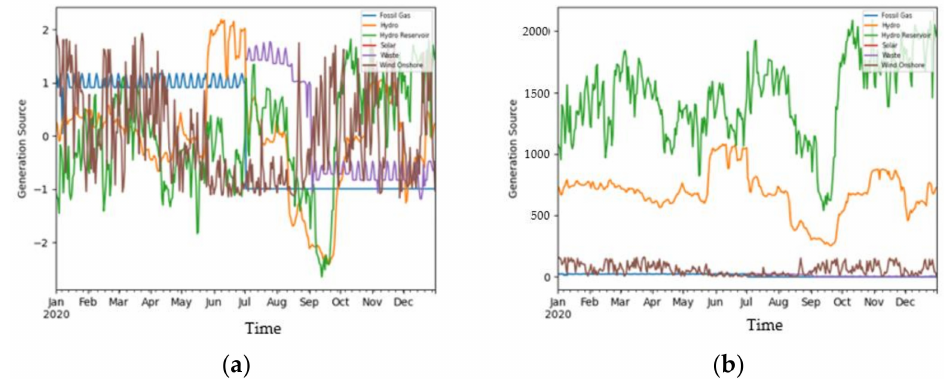
Figure 5. This figure represents the Norway (NO1) electricity generation. ( a ) Shows an approach using data standardization which has been defined in Formula (3); ( b ) Shows the electricity generation sources in MWh. Figures 3–5 got generated using the same code in Python.